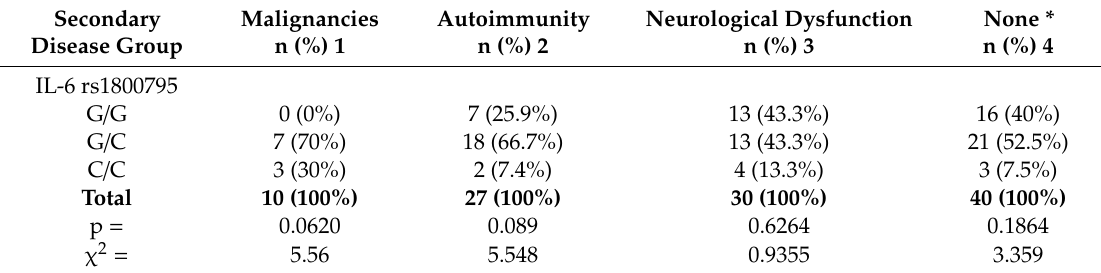
Table 4. Frequencies of the IL-6 promotor rs1800795 genotype in Lyme borreliosis patients according